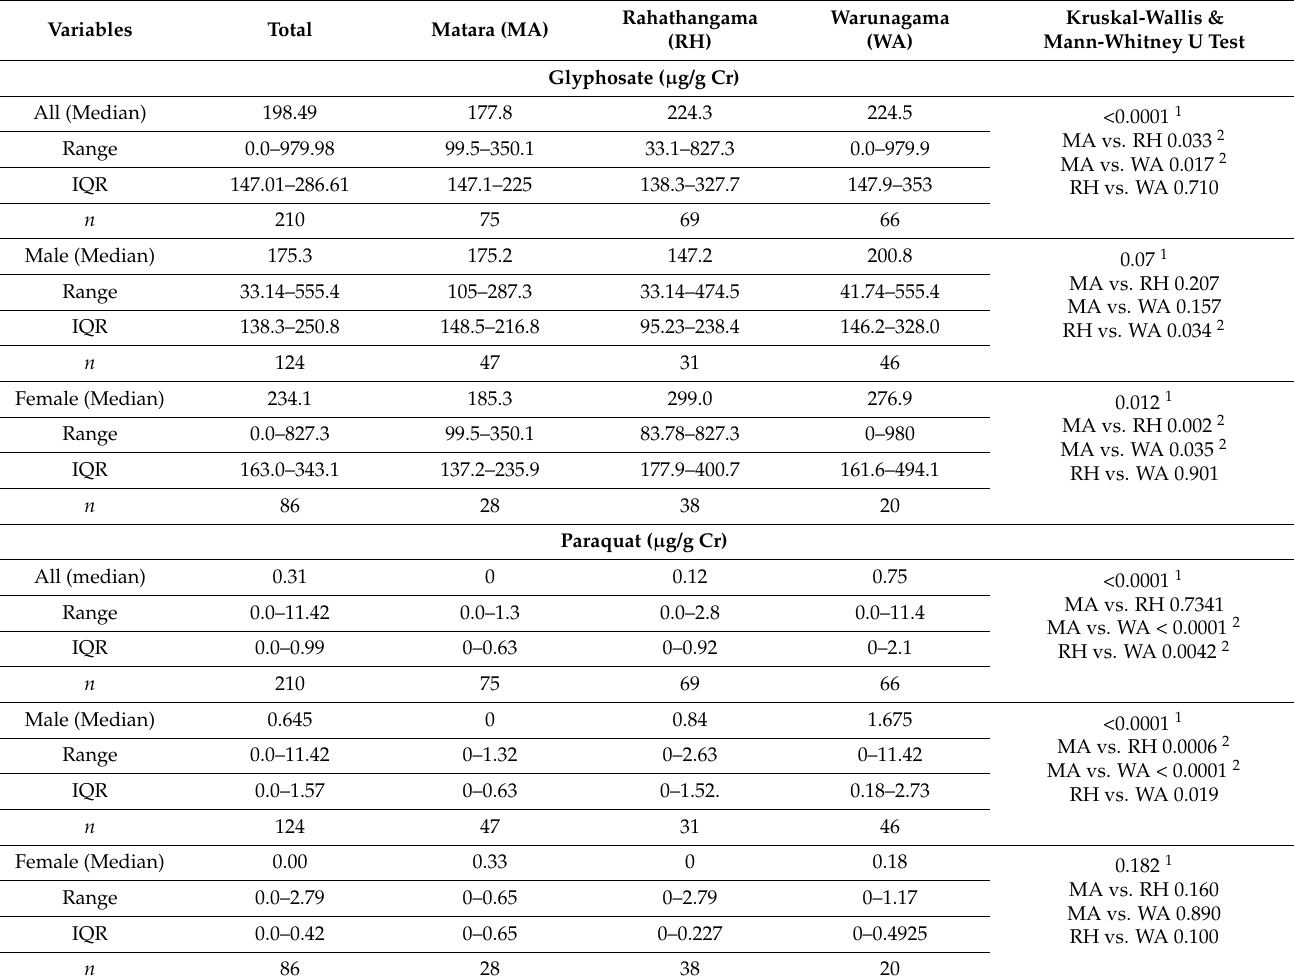
Table 2. Creatinine-adjusted urinary Glyphosate and paraquat levels in male and female farmers in Matara, Rahathangama and